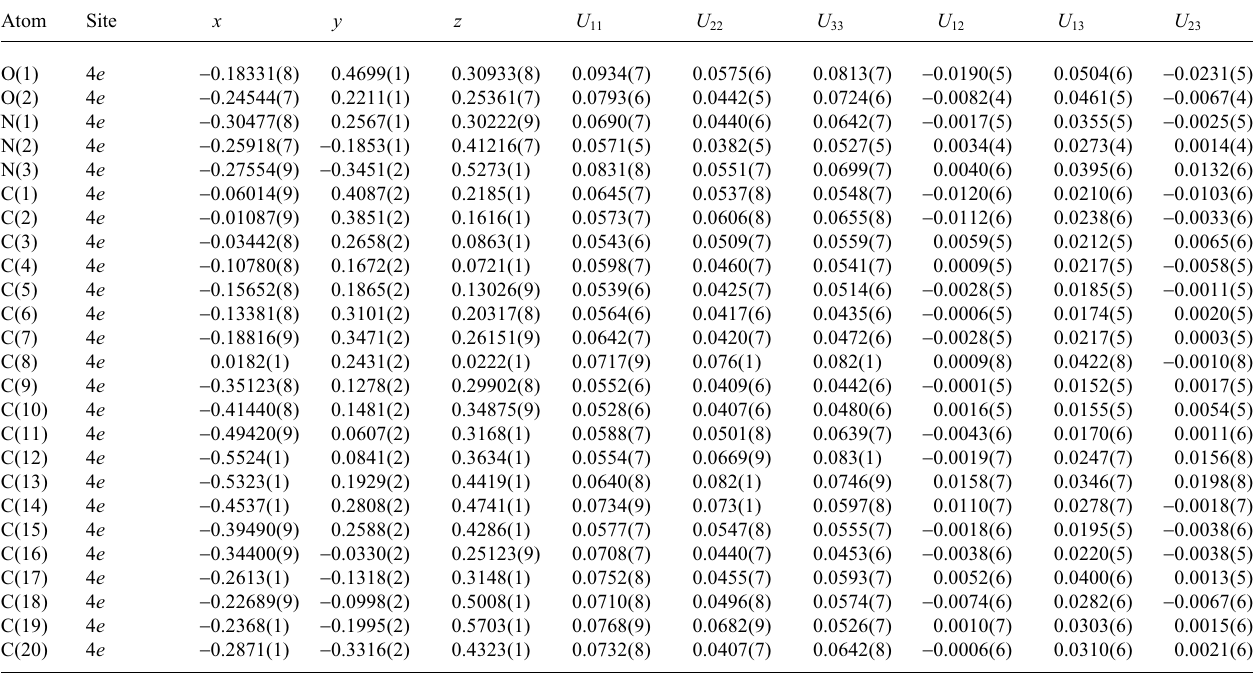
Table 3. Atomic coordinates and displacement parameters (in Å 2 )